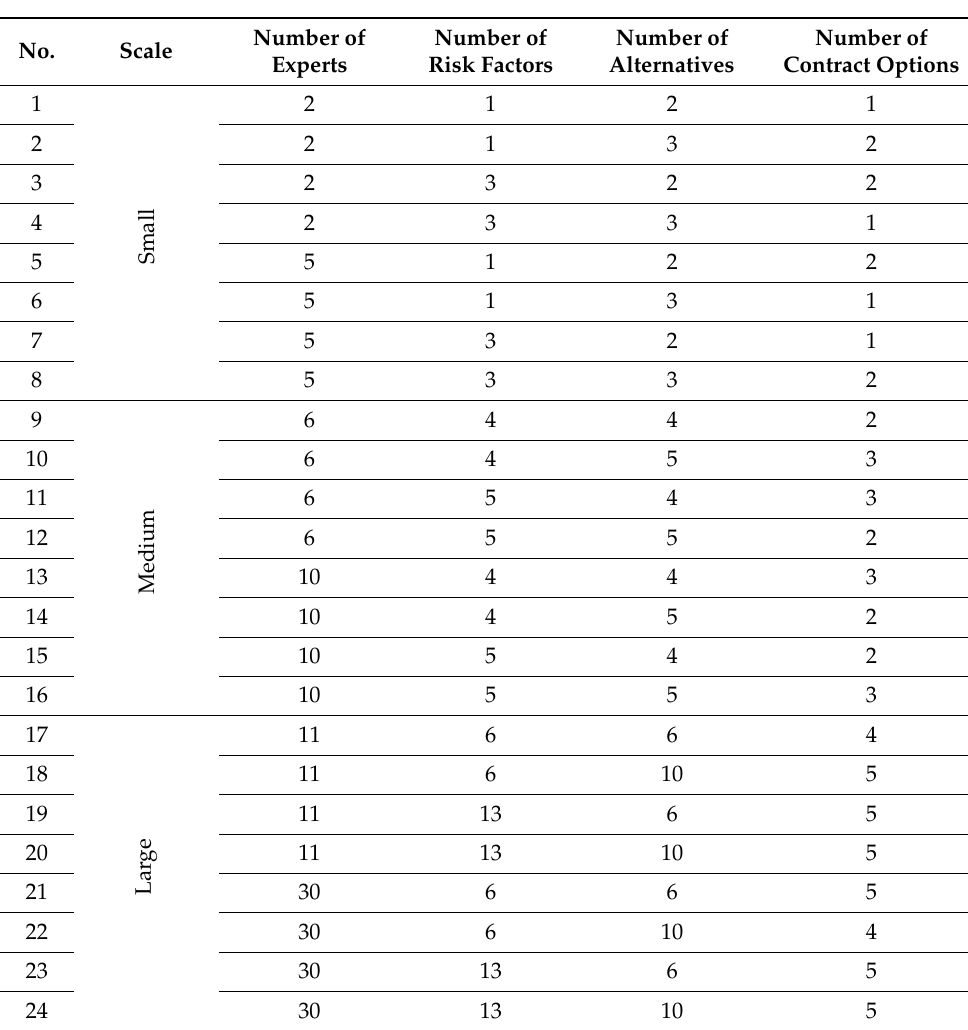
Table 7. The Designed Case Studies (Taguchi